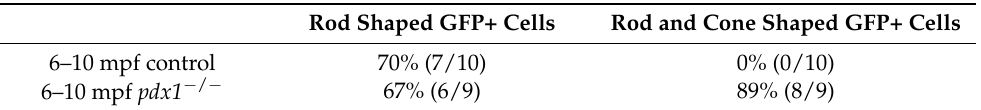
Figure 7. Photoreceptors are restored from neurod -expressing progenitors. ( a – c ) In neurod:GFP transgenics, strong GFP is detected mainly in the INL in controls, and in the INL and ONL of pdx1 mutants ( a ). In controls, neurod:GFP labeled rod-shaped cells in the ONL were observed. In pdx1 − / − mutants, neurod:GFP labeled rod and cone shaped cells in the ONL in most mutants ( b , c , see Table 2). Sections were counterstained with DAPI (blue). A significant increase in GFP positive cells in the INL was detected in pdx1 − / − mutants ( d ). Box plot extends from 75% to 25%, whiskers showing minimum and maximum, line indicates median, n = 10 controls, 9 pdx1 − / − . Scale bar: 50 µ m. (INL, inner nuclear layer; ONL, outer nuclear layer). Table 2. Frequency of samples with a field of view showing rod and/or cone shaped GFP+ cells in the ONL.